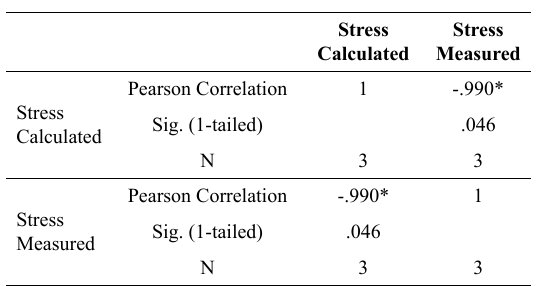
Table 13. Statistical results of comparison of experimental and calculated stress using aging times.